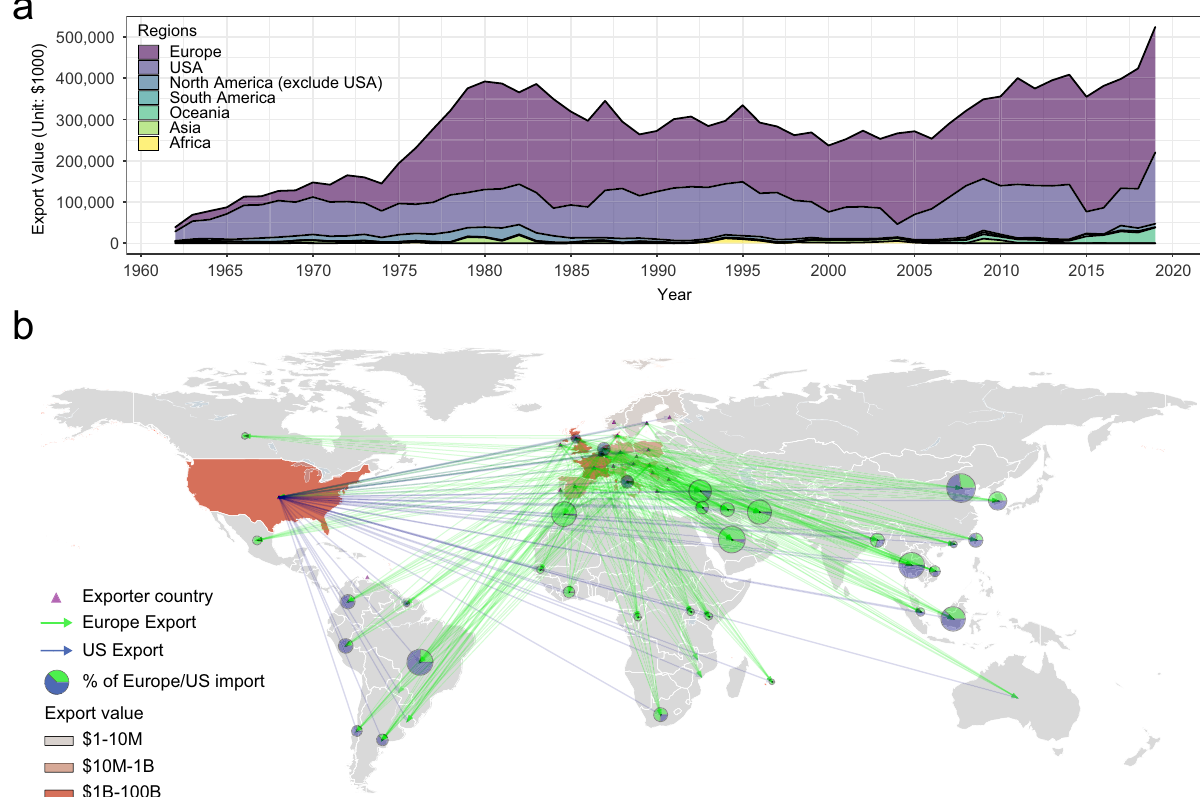
Fig. 6 Intercontinental trade of live poultry. a Share of intercontinental trade of live poultry by exporting continents or country from 1962 to 2019. Export between 1962 and 1985 is based on the trade data of live fowls at in Observatory of Economic Complexity database. Export between 1986 and 2019 is based on the trade of live chickens ( Gallus domesticus ) and guinea fowls ( Numida meleagris ) according to the Food and Agriculture Organization of the United Nations. b Cumulative intercontinental export of live poultry originated from Europe and the US between 1962 and 2019. Forty-six importers represented by isolates in the phylogenetic analysis (Fig. 4) are shown. Cumulative trade volumes between $24 million (Belgium) and $754 million (China mainland) are designated with pie charts showing the comparisons between total import values from Europe and from the US. The sizes of the pie charts are proportional to the volumes of